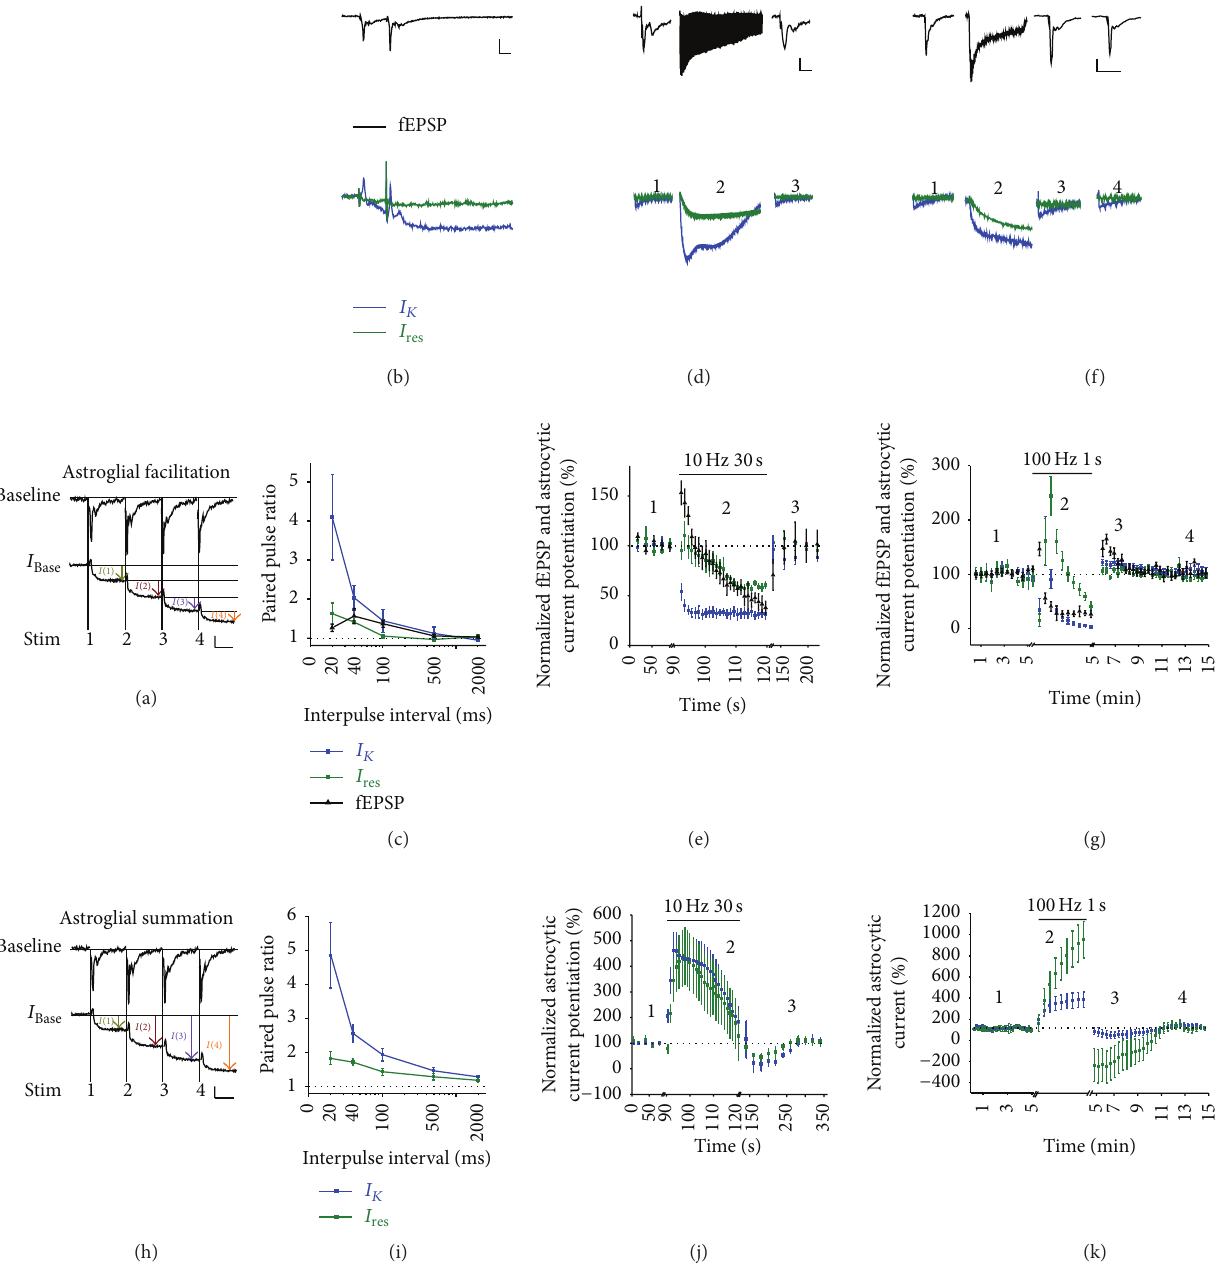
Figure 2: Short-term plasticity of astroglial potassium and residual currents quantified using two different methods. Simultaneous recordings of field excitatory postsynaptic potentials (fEPSPs) and synaptically evoked astroglial currents were carried out in hippocampal CA1 region upon stimulation of Schaffer collaterals. (a, h) Two different methods used to quantify astroglial currents are illustrated. fEPSPs (top) and astroglial currents (bottom) during the first four stimulations of a 10Hz train are shown. The peak amplitude of each response was measured either in reference to (a) the prestimuli baseline, taken just before each stimulation (astroglial facilitation) or (h) to the initial resting baseline ( 𝐼 Base ), taken before the first stimulation (astroglial summation). Scale bars = 0.05 mV for fEPSP, 20 pA for astroglial currents, 25 ms. (b, d, and f) Sample traces are shown for fEPSPs (top) and pharmacologically isolated astrocytic potassium 𝐼 𝐾 (bottom, blue) and residual 𝐼 res (bottom, green) currents in response to (b) paired-pulse stimulation (interpulse interval = 40 ms; scale bars = 0.5 mV for fEPSP, 20 pA for astroglial currents, 25 ms), (d) repetitive stimulation (10Hz for 30s; scale bars = 0.2 mV for fEPSP, 40 pA for astroglial currents; 5 s for astroglial currents and 50ms for fEPSP), and (f) tetanic stimulation (100 Hz for 1s; scale bars = 0.2 mV for fEPSP, 20 pA for astroglial currents; 7.5 s for astroglial currents and 60ms for fEPSP). Quantifications using (c, e, and g) astroglial facilitation or (i, j, and k) astroglial summation methods are shown for (c, i) paired-pulse ratio, and normalized fEPSP slope and astrocytic current amplitudes during (e, j) repetitive or (g, k) tetanic stimulation. Numbers indicate extracted traces before (1), during (2), and after (3, 4) each stimulation. Mean ± SEM are shown for (c), (e), (g), (i), (j), and